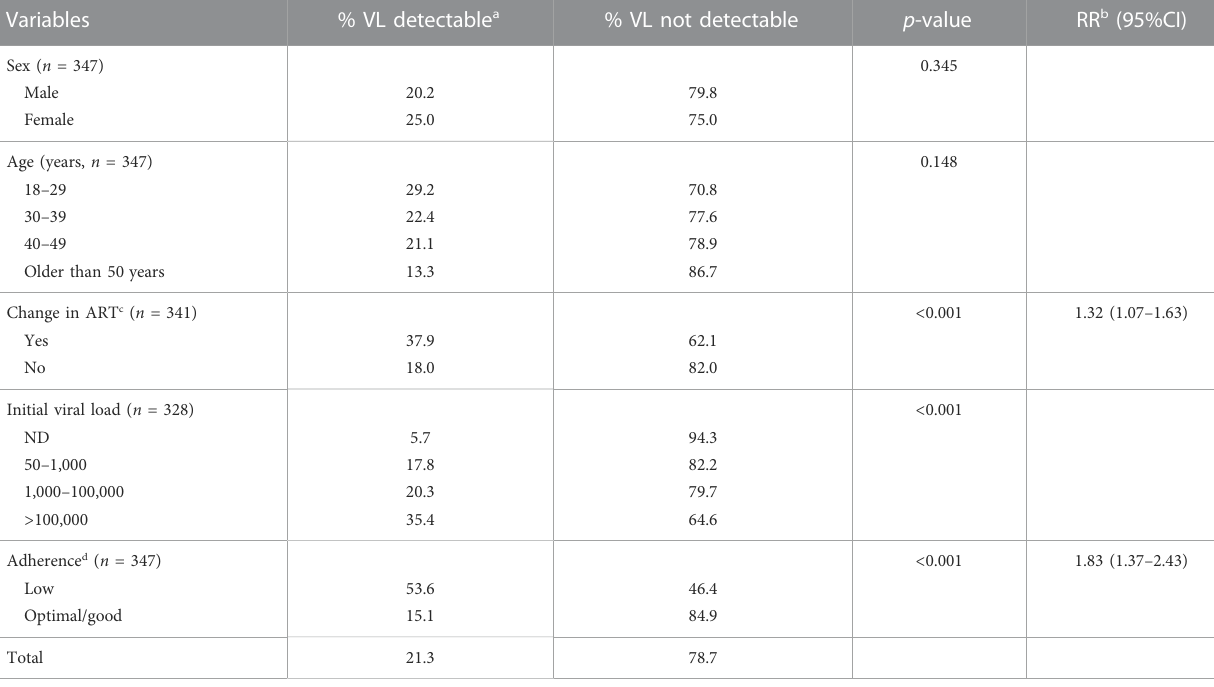
TABLE 5 Viral load in people living with HIV/AIDS, according to demographic, therapeutic, initial viral load and adherence, Hospital Universitário de Brasilia, Brasilia, Brazil, 2019.